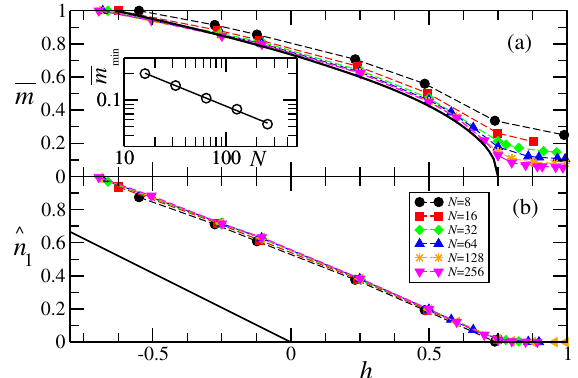
FIG. 4. (a) The time-averaged magnetization versus the aver- aged energy density h . We have simulated various multimode photonic networks described by Eq. (17) with N ¼ 8 , 16, 32, 64, 128, 256. The bold solid line is the best asymptotic ( N → ∞ ) fit indicating a square-root singularity of the magnetization, i.e., ffiffiffiffiffiffiffiffiffiffiffiffiffiffiffiffiffi p ¯ m ≈ 0 . 85 0 . 75 − h . Inset: The asymptotic value ¯ m of time- min averaged magnetization (circles) versus the number of nodes N . The solid line is the best fit to the numerical data and ffiffiffiffi p ≈ 0 . 75 = N demonstrates a convergence to zero as ¯ m . min (b) The time-averaged optical power of the ground-state super- mode for networks of different number of nodes N . We have used the same scaling variable ˆ n 1 as in Fig. 3. The condensation transition, corresponding to ˆ n 1 ¼ 0 , occurs for the same value of ≈ 0 . 75 as the one that signifies the transition from a h ¼ h c ferromagnetic to a paramagnetic behavior in (a). In all cases we have considered an initial averaged optical power a ¼ 1 , coupling constant J 0 ¼ 1 . 2 , while the nonlinearity is χ ¼ 1 . In this case, 1 the maximum energy density is h max ¼